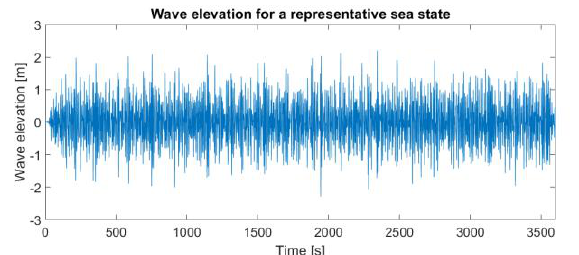
Fig. 10. Wave elevation signal of a representative sea state of method C.